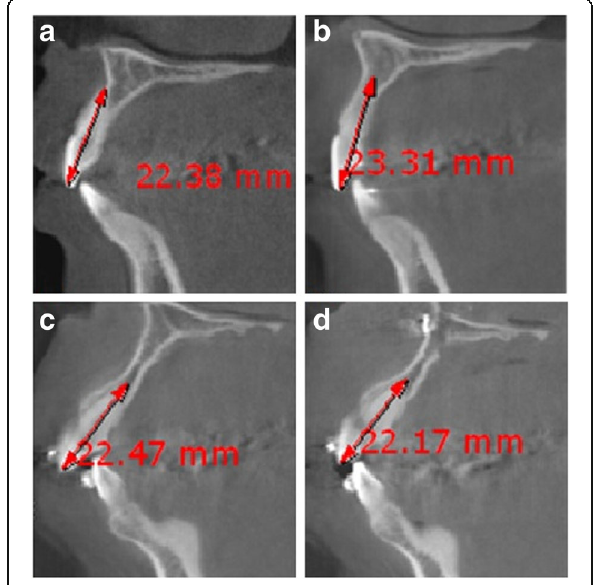
Fig. 1 Measurement of tooth length on CBCT image of group A on T0 ( a ) and T1 ( b ) and group B on T0 ( c ) and T1 ( d )